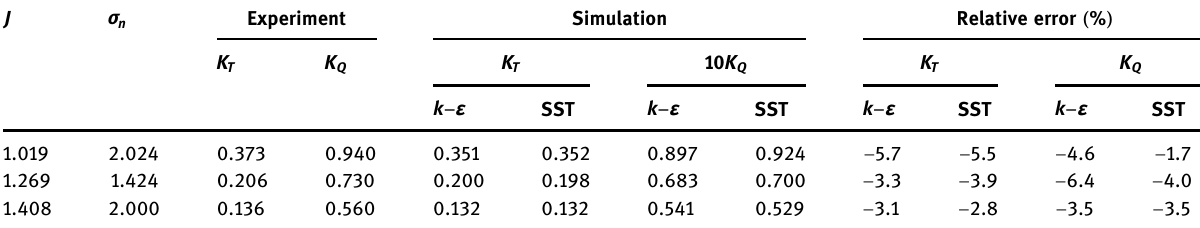
Table 6: Comparison results between experimental test and numerical simulation using the Kunz cavitation model J σ n Experiment